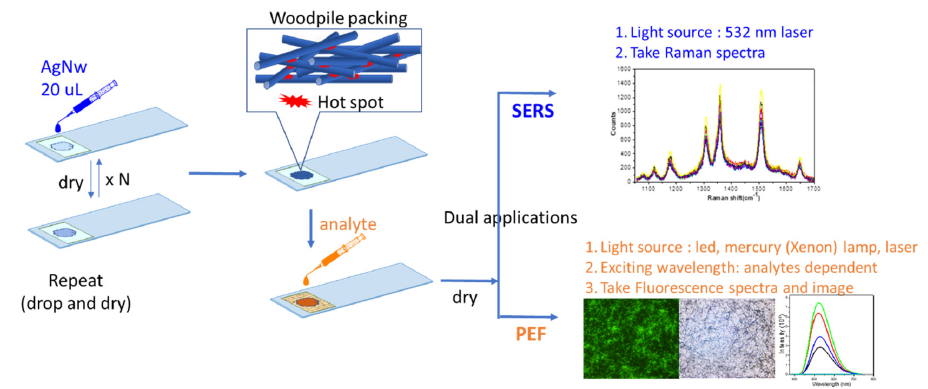
Figure 1. Construction of a 3D random crossed-wire woodpile (RCW) and preparation for analyte detection for surface- enhanced Raman scattering (SERS) and plasmon-enhanced fluorescence (PEF), respectively. The red color region in the woodpile graph indicates the hot spot.